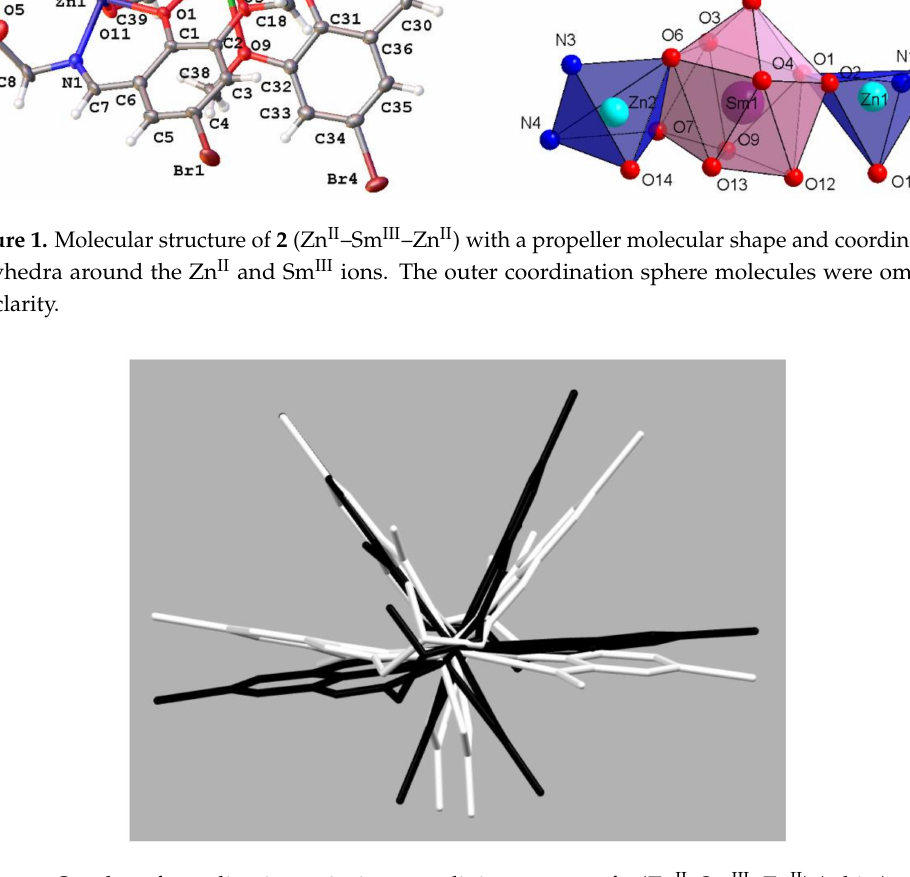
Figure 2. Overlay of coordination units in monoclinic structure of 2 (Zn II –Sm III –Zn II ) (white) and in trigonal structure of 3 (Zn II –Eu III –Zn II ) (black)—view along the Zn II –Ln III –Zn II